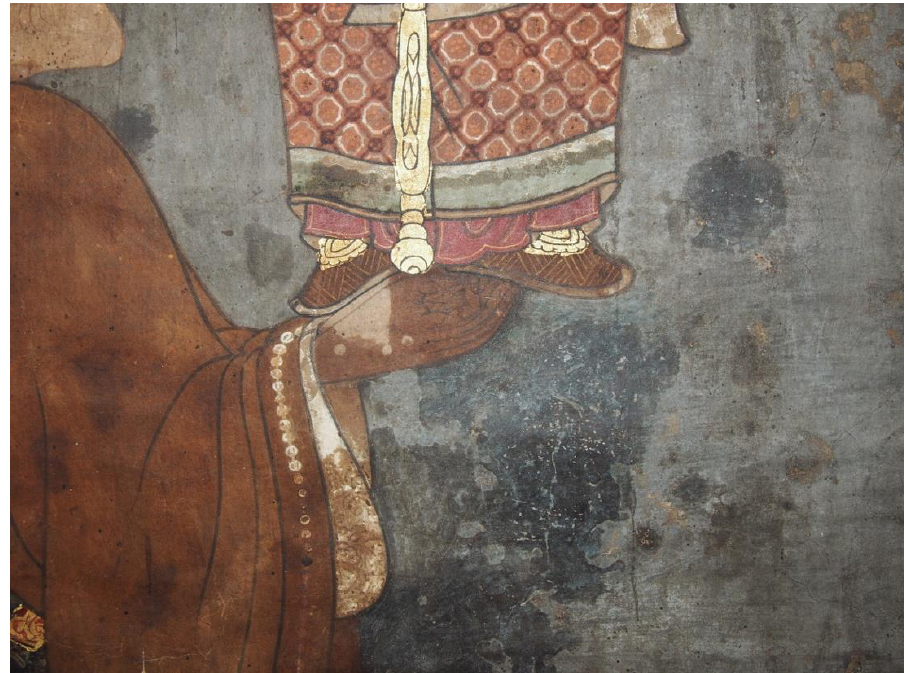
Figure 3. Keikōin Nun and Uhō Dōji , Edo period, 17th century, hanging scroll, ink and colors on paper, Figure 3. Keik ¯ oin Nun and Uh ¯ o D ¯ oji , Edo period, 17th century, hanging scroll, ink and colors on paper, 34 × 81 cm. Gakushūin University, Tokyo. Detail of mudra. 34 × 81 cm. Gakush¯uin University, Tokyo. Detail of